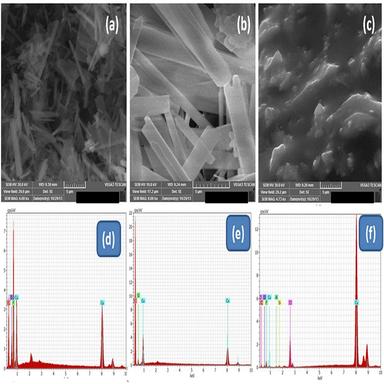
SEM images of (a) Cu-PFBA, (b) Cu-SA and (c) Cu-TCPFOSi system and EDX spectra of (d) Cu-PFBA, (e) Cu-SA and (f) Cu-TCPFOSi system.